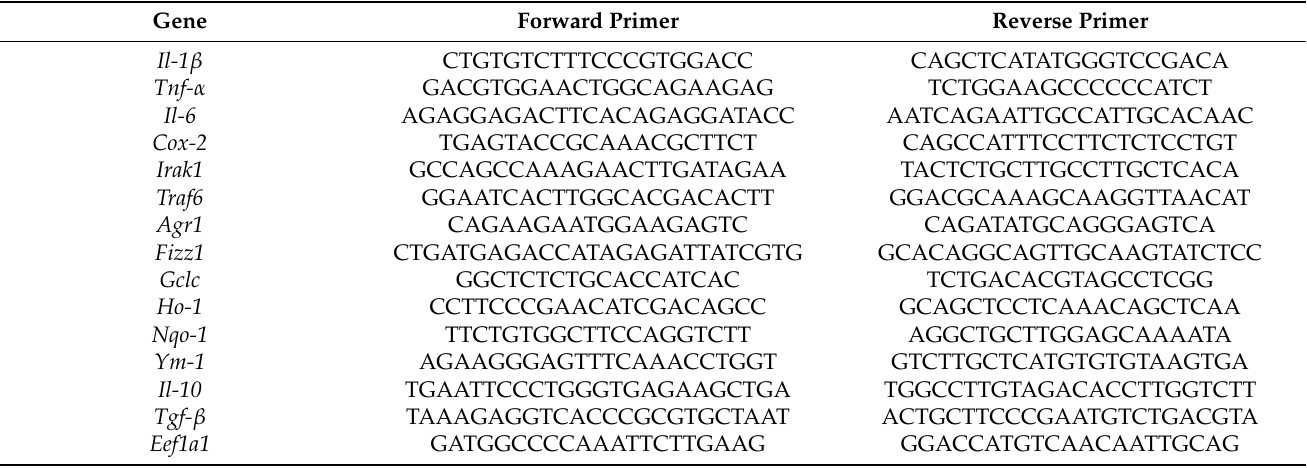
Table 1. Oligonucleotide sequences of the primers used in quantitative